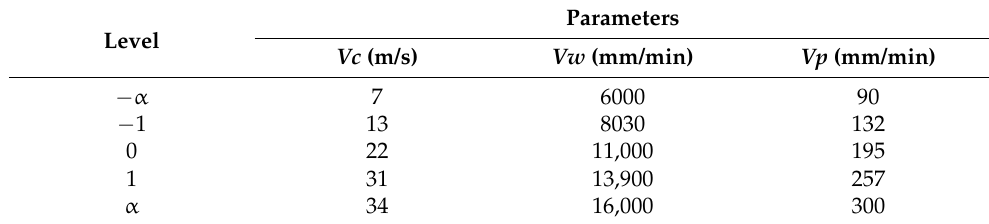
Table 3. The ranges of the parameters used depending on the levels of α